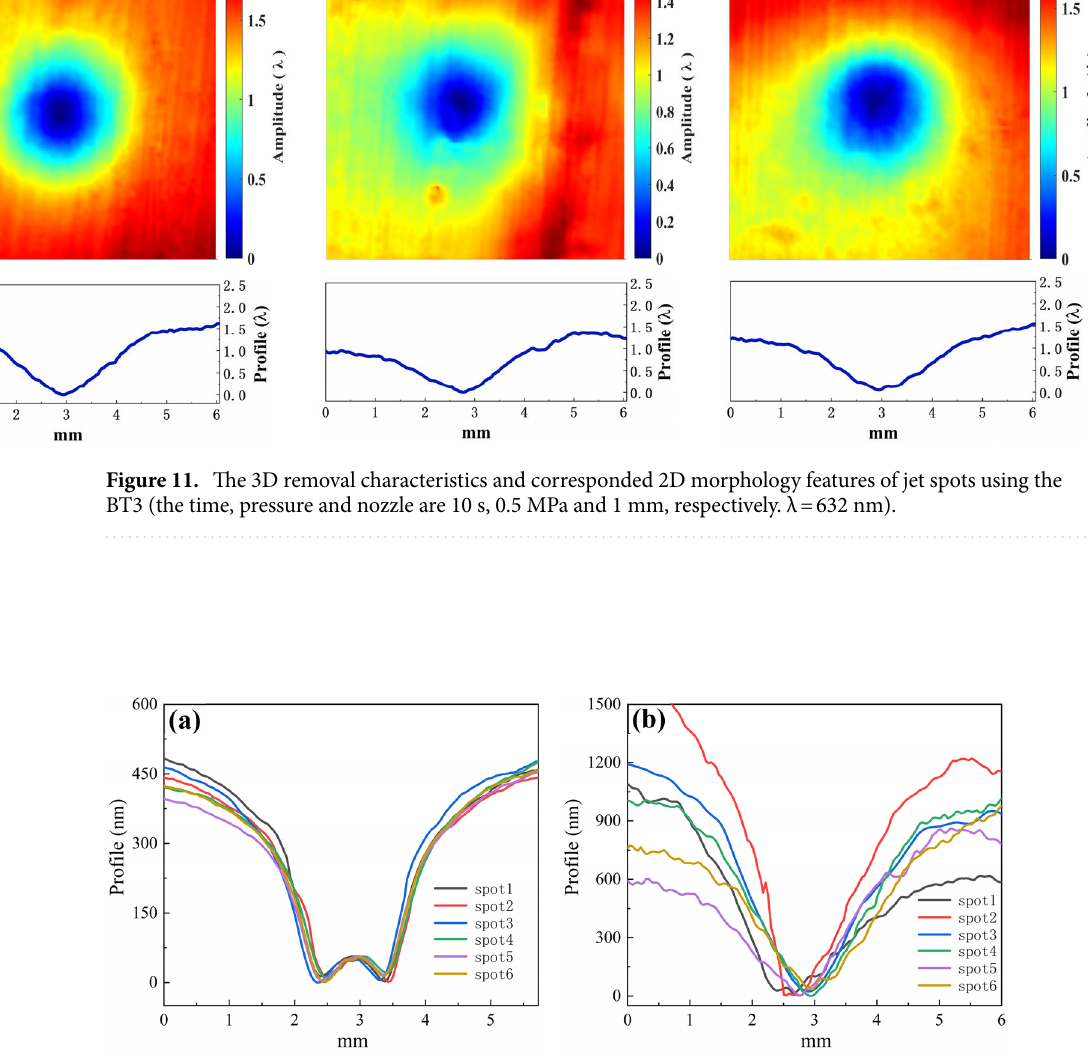
Figure 12. The 2D morphology features of jet spots using ( a ) the BT2 (the time, pressure and nozzle are 1 min, 0.5 MPa and 1 mm, respectively. λ = 632 nm) and ( b ) the BT3 (the time, pressure and nozzle are 10 s, 0.5 MPa and 1 mm, respectively. λ = 632